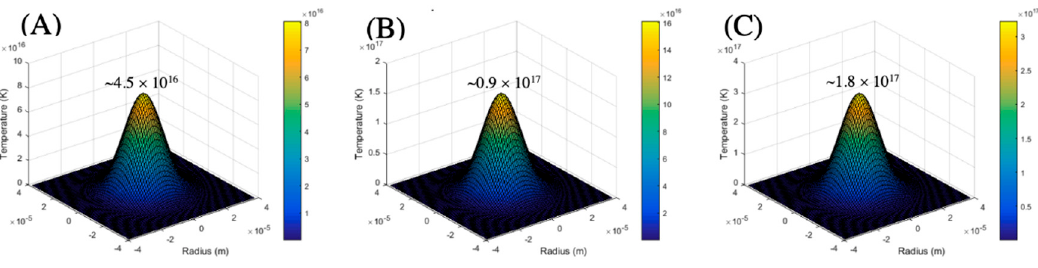
Figure 2. The 3D radial temperature gradient profiles for laser power of ( A ) 5 W; ( B ) 9 W and ( C ) 12 W.